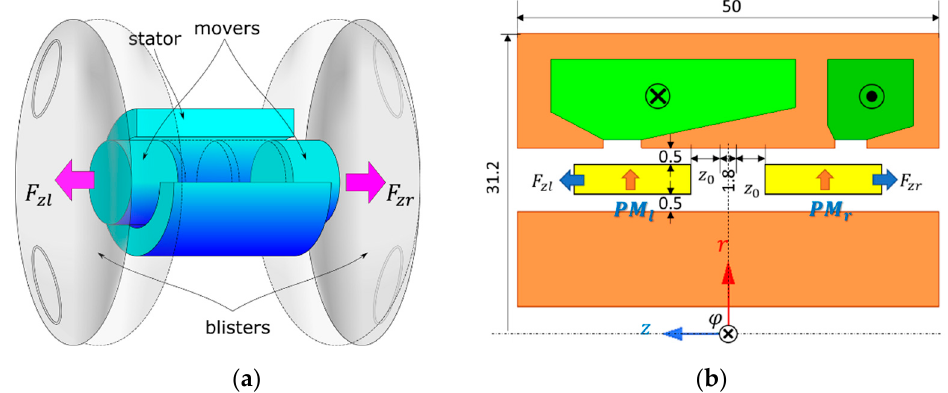
Figure 9. Double-mover LOA; ( a ) working principle showing the two movers pushing the ventricular chambers; ( b ) LOA electromagnetic configuration; PM l , PM r : PM movers acting on the LV and RV; F zl , F zr : thrust acting on PM l and PM r ; z 0 : mover position with respect to the backward bound; and sizes are in mm. Republished with permission of IEEE.